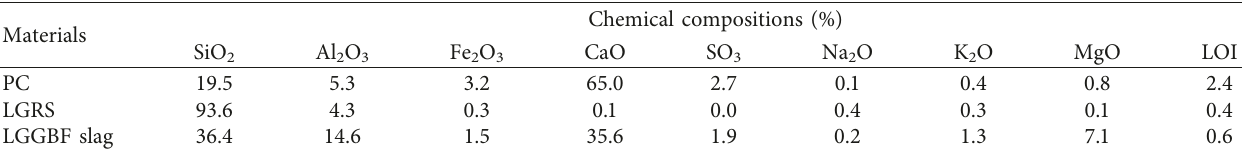
Table 3: Chemical compositions of PC, LGRS, and LGGBF